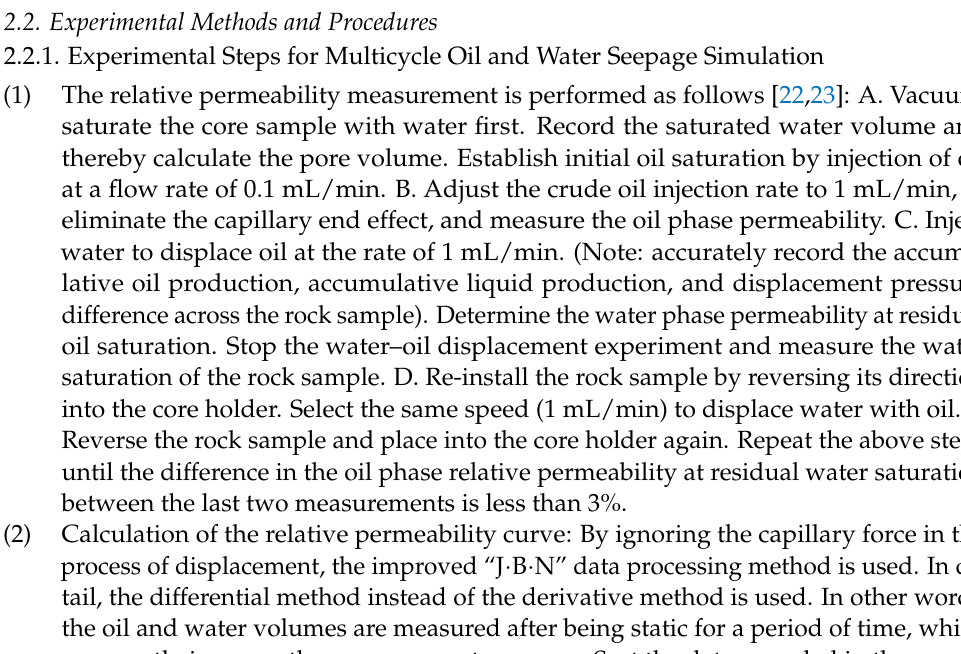
Figure 1. Schematic diagram of experimental flow of mutual